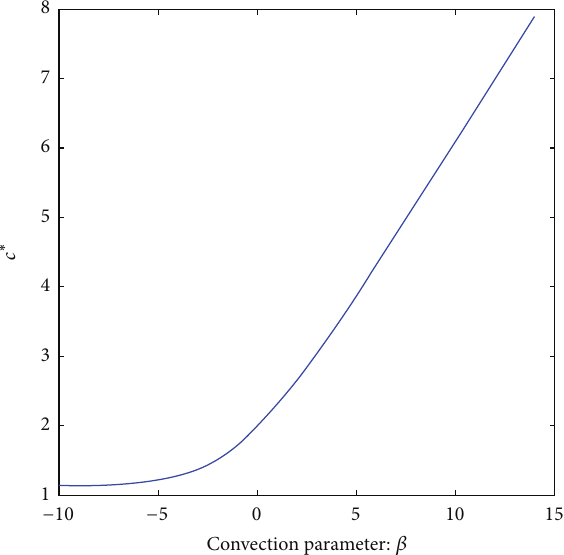
Figure 16: Plot of how 𝑐 ∗ changes with 𝑘 for ℎ 󸀠 (𝑢) = 𝛼 + 𝛾𝑢 . For a comparison, refer to Figure 10, where ℎ 󸀠 (𝑢) = 𝑘𝑢